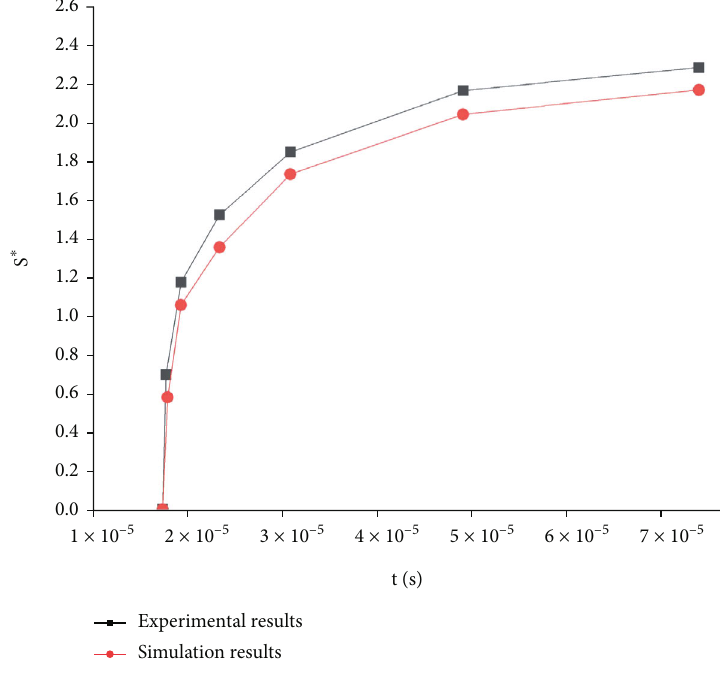
Figure 2: Variation trend of dimensionless spread area with time in the experiment and